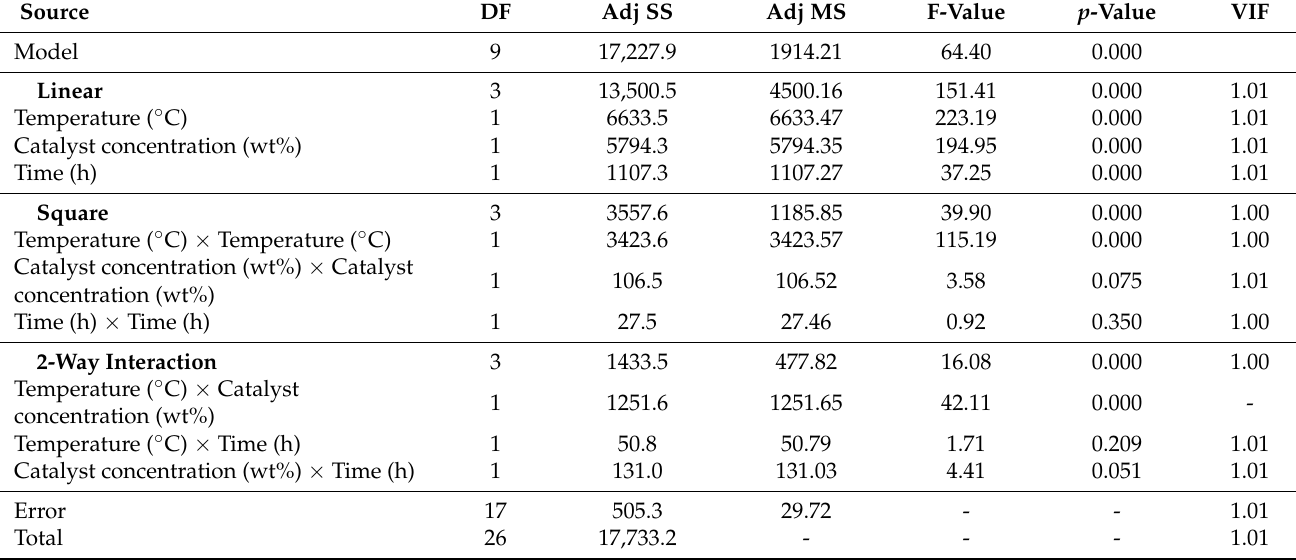
Table 1. Analysis of variance of the GA